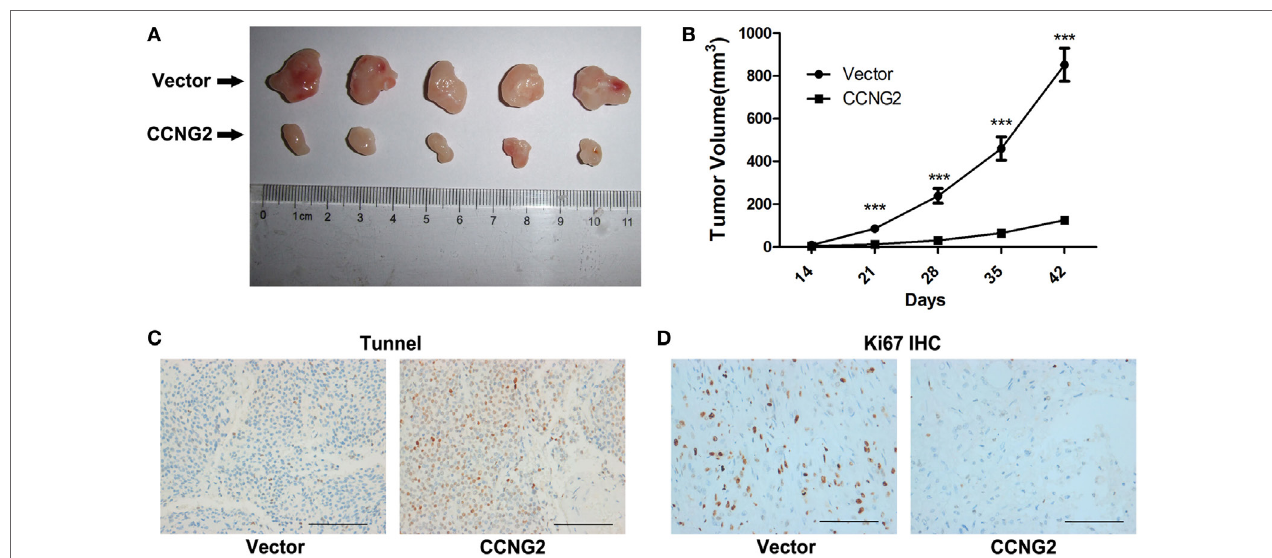
FigUre 7 | CCNG2 in vivo tumor formation from U251 cells in nude mice. Stable CCNG2 transfected and empty vector U251 cells were implanted subcutaneously in the left flank of nude mice. (a) After 42 days, mice were sacrificed and tumors were excised. (b) Effect of CCNG2 on tumor volume in a nude mice model. Apoptosis and Ki67 expression were detected by (c) TUNEL and (D) immunohistochemistry assays. Scale bars: 100 µm. *** P < 0.001 by the unpaired two-tailed Student’s t